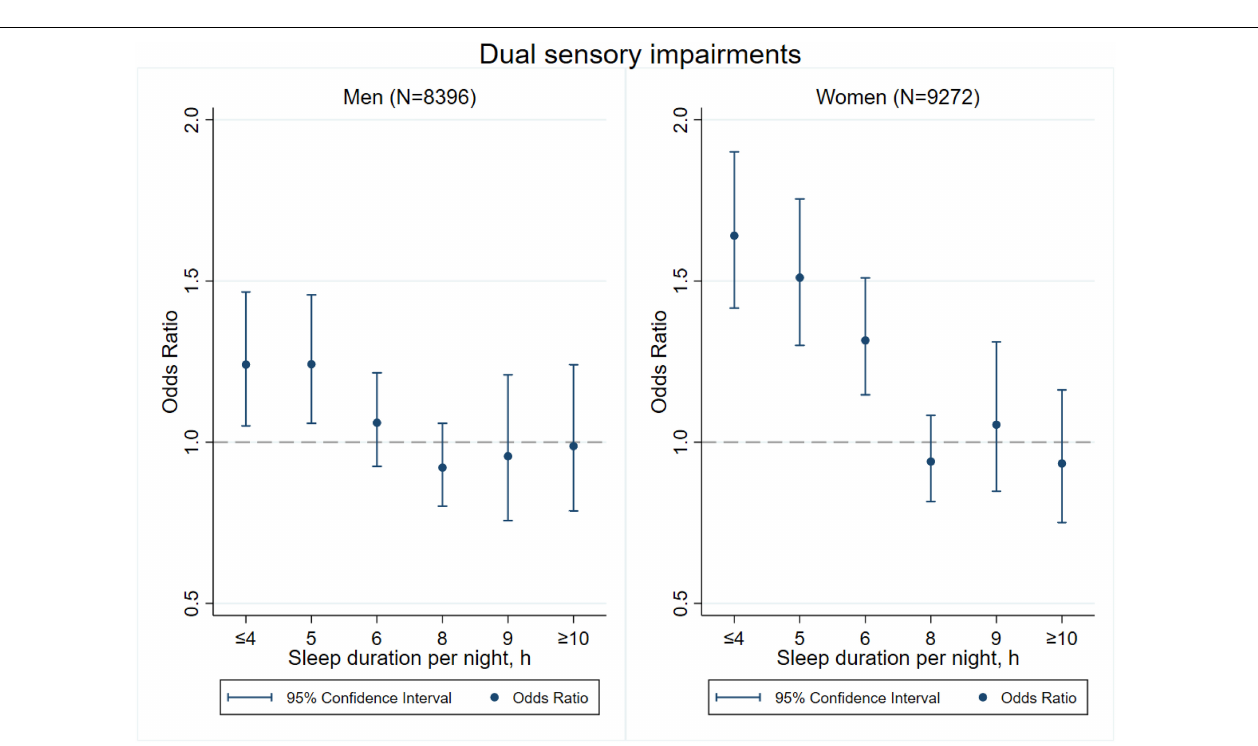
FIGURE 5 | Gender-specific effect of sleep duration on dual sensory impairments.